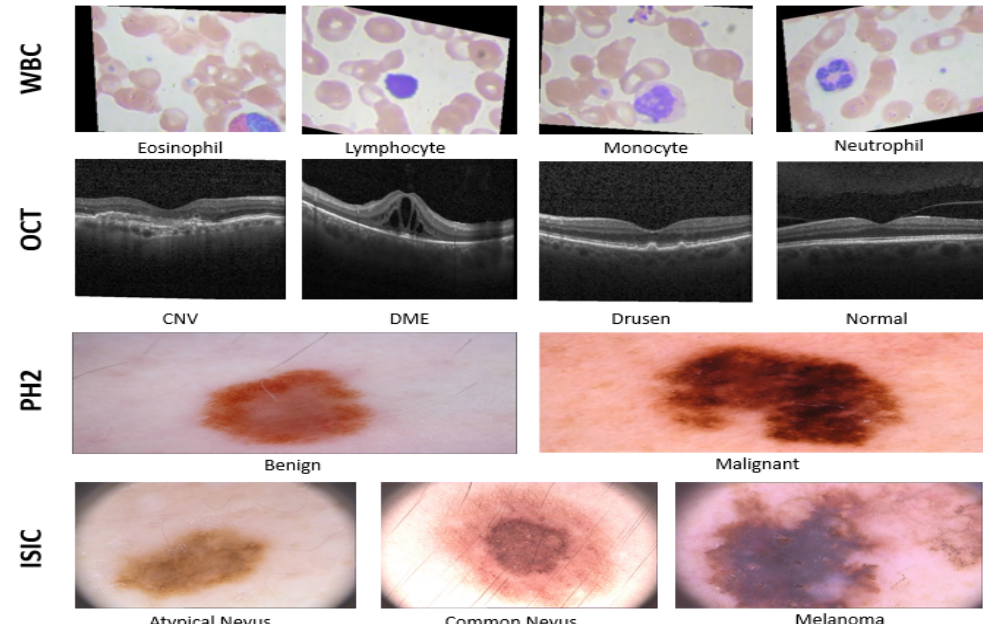
Figure 3. Sample of images from: ISIC, PH2, WBC, and OCT